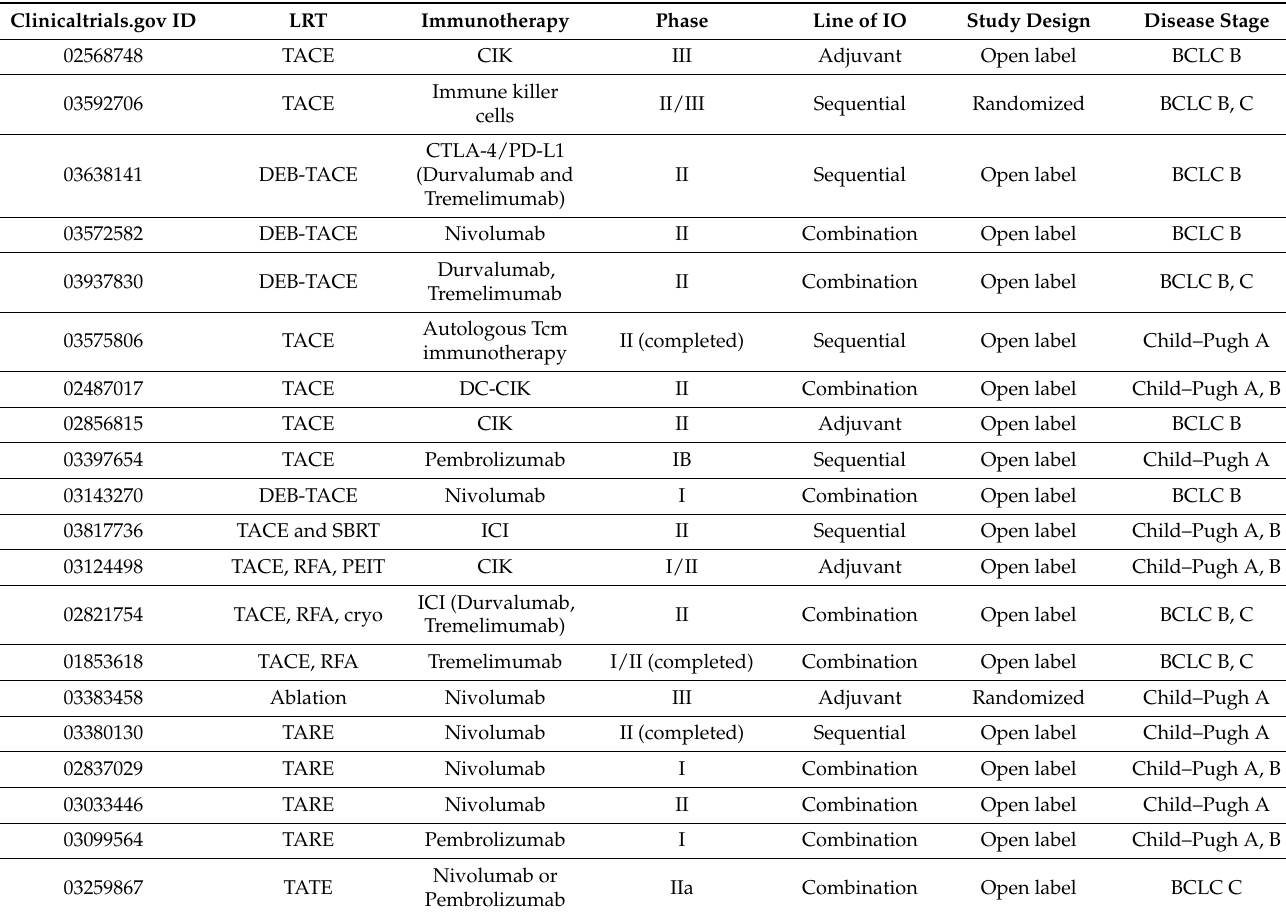
Table 2. Trials on LRT and immunotherapy